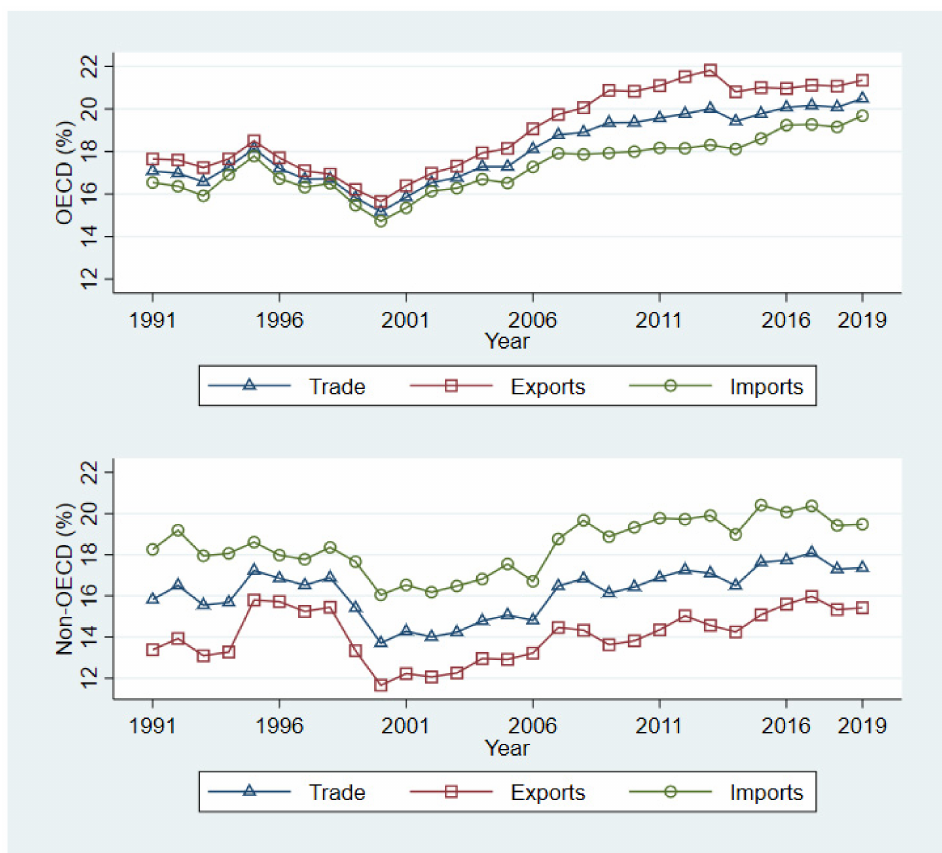
Figure 2. Trends of Climate Share: OECD and non-OECD. Note: authors’ calculation by using the UN Comtrade data. Source: UN Comtrade. International Trade Statistics-Import/Export Data (accessed on 8 May 2021)